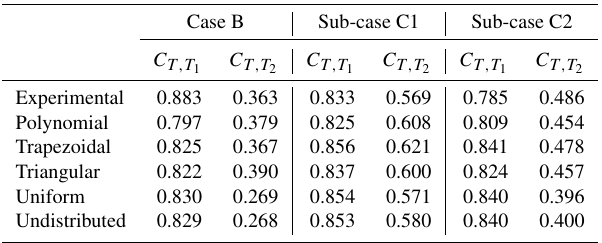
Table 5. Thrust coefficients for case B and sub-cases C1 and C2 when using the k - ε turbulence model for the first and second wind